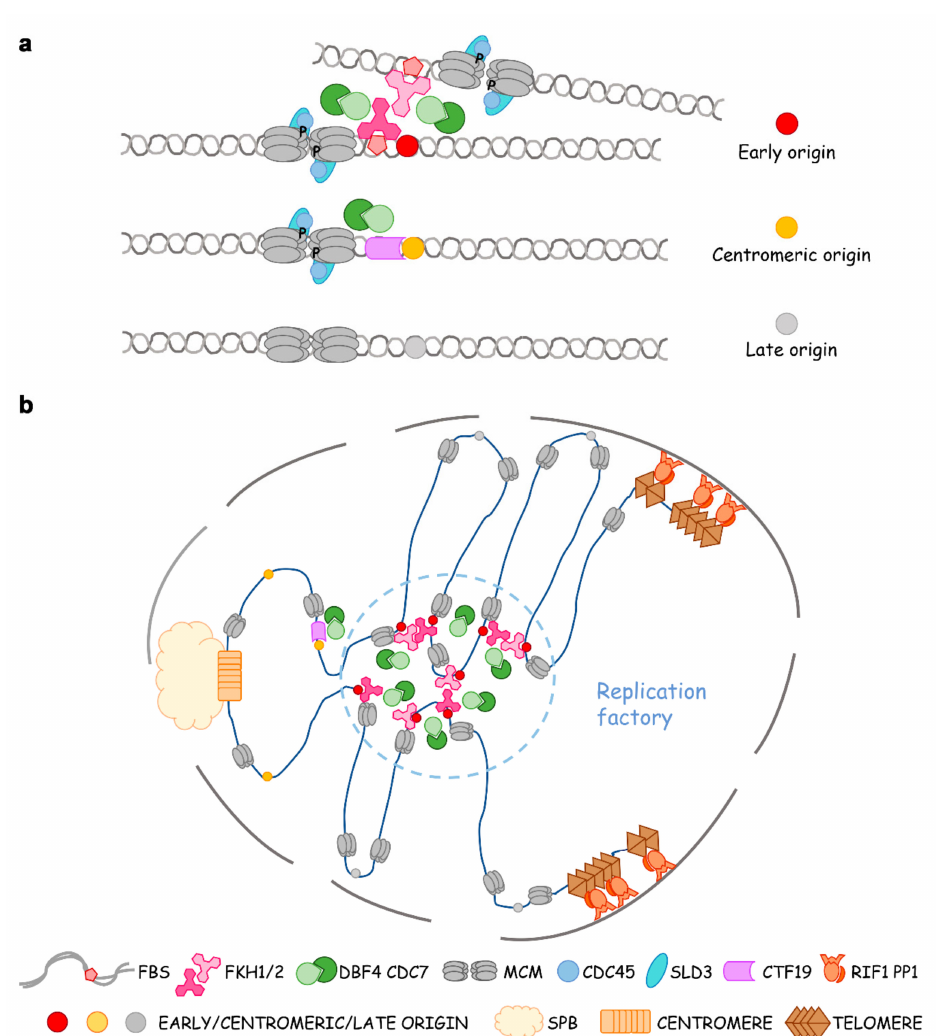
Figure 3. Fox TFs determine the global replication timing program through preferential recruitment of limiting factors, origin clustering, repositioning, and making replication factories. ( a ) Dbf4-dependent kinase (DDK is recruited to chromosomal arms and pericentromeric origins via Fkh1 / 2 and Ctf19p-Okp1p-Mcm21p-Ame1p (COMA), respectively. Dbf4 recruitment defines an